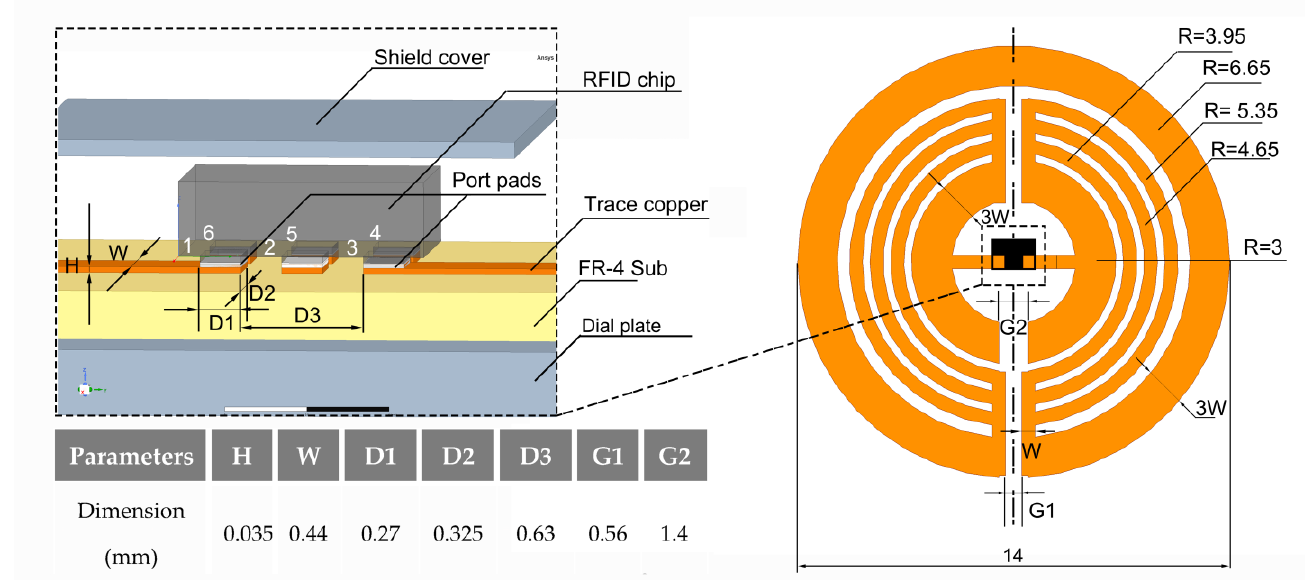
Figure 5 . RFID tag Antenna and chip Geometry .